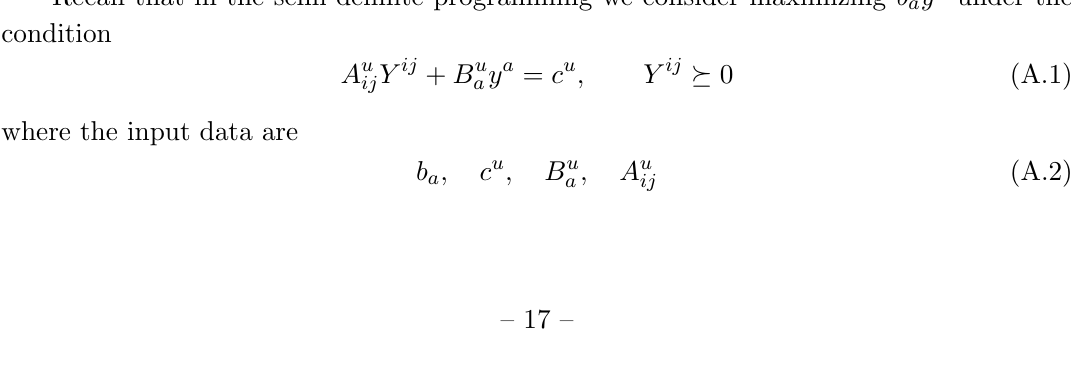
JHEP06(2019)084